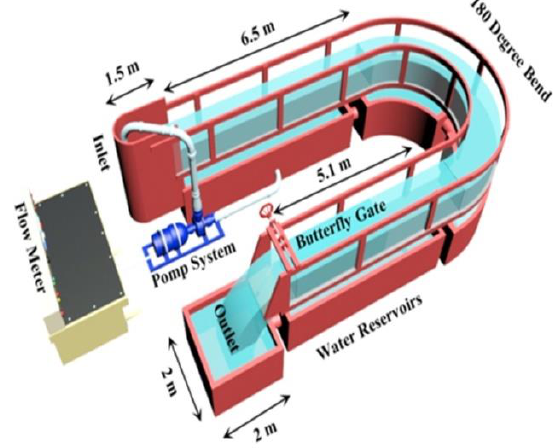
Figure 1. A view of the laboratory flume (Vaghefi et al.